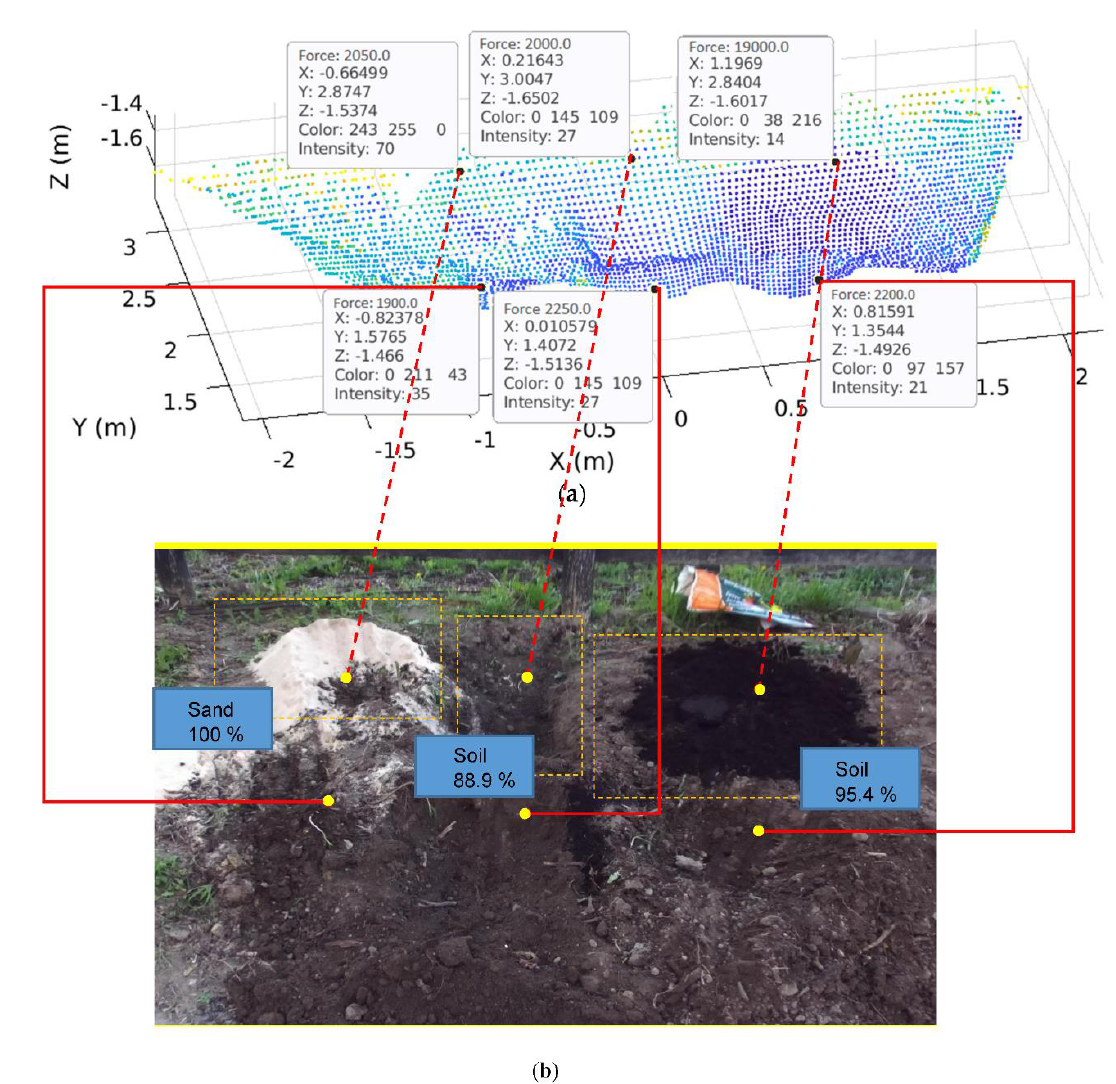
Figure 28. The constructed 5D map: ( a ) 5D point cloud map with respective material properties; ( b ) Actual photograph to show the monitoring target area.